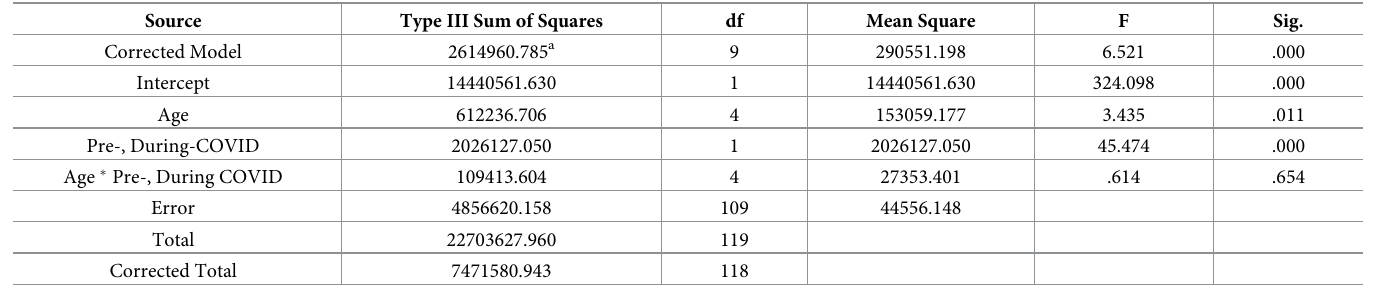
Table 6. Between-subjects effects pre- and during pandemic on telomere length controlling for age.